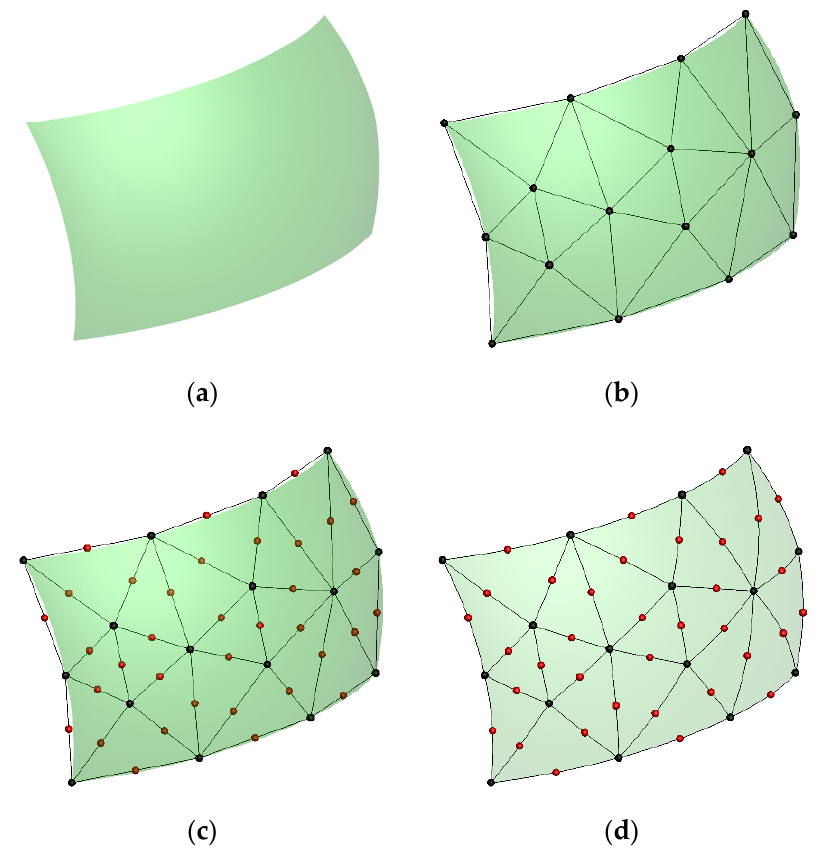
Figure 2. Illustration of the high-order surface re-mesh. ( a ) Surface of curved boundary; ( b ) initial boundary mesh; ( c ) midpoints introduced; and ( d ) high order curved surface. The black points are the vertexes of the mesh, and the red points are the newly added control points.